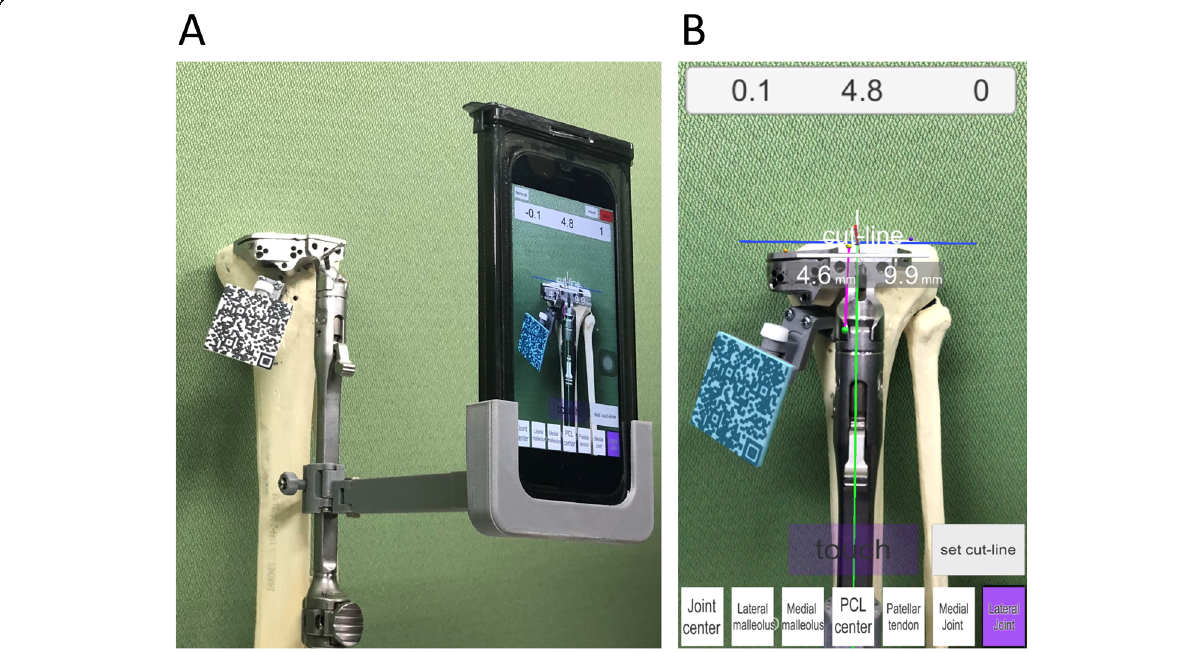
Fig. 5 Resection of the proximal tibia of sawbone using the AR-KNEE system. a We cut the sawbone viewing the cutting angle and cutting amount of the bone following registration of the bone landmarks. The smartphone can be attached to the tibial bone resection guide as one option. b Screenshot image of ( a ). The AR-KNEE system showed the cutting block placed on the following parameters in this case: (1) varus angle of 0.1° on the long tibial axis (green line), (2) posterior slope of 4.8° on the long tibial axis (green line), (3) internal rotation angle of 0° on the anteroposterior axis (pink line), (4) 4.6-mm of bone resected from the medial tibia plateau, and (5) 9.9-mm of bone resected from the lateral tibia plateau. The white line indicates the resection